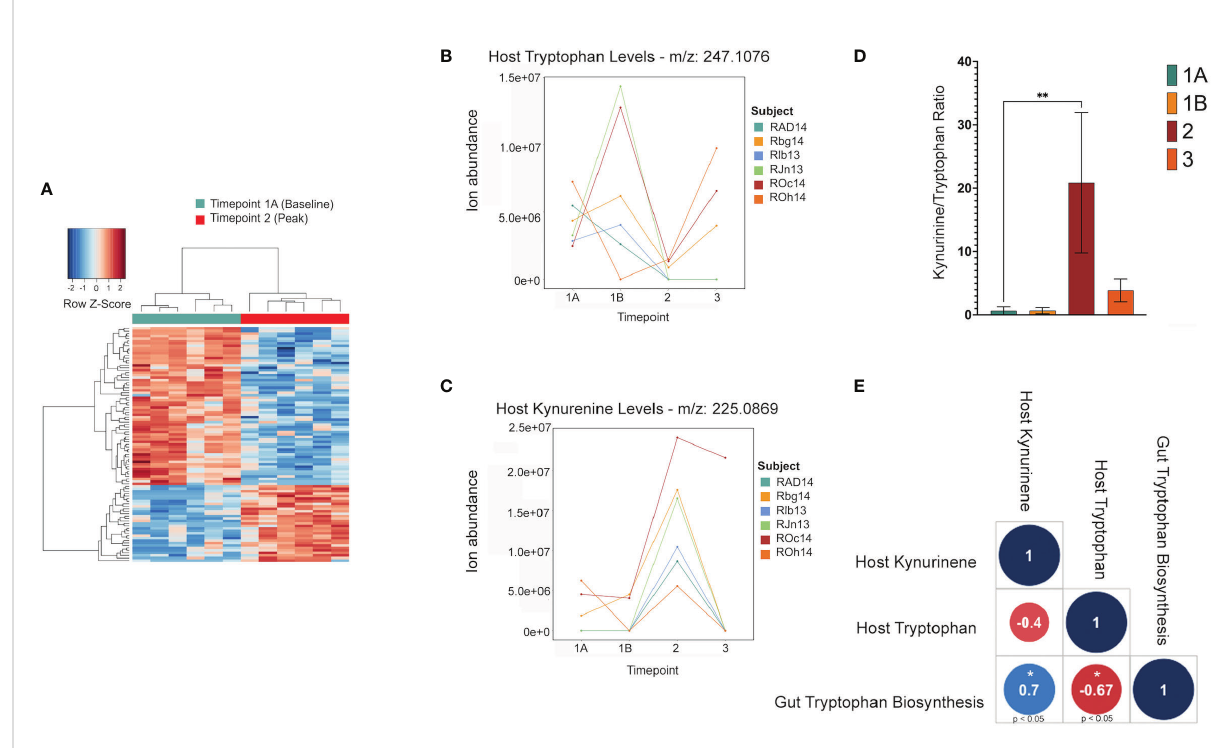
FIGURE 4 Shifts in the host tryptophan/kynurenine pathway may be linked to microbial production of tryptophan in the gut. This data shows major shifts in the host metabolome where red indicates a signi fi cant increase, and blue indicates a signi fi cant decrease (A) . LC-MS data of host metabolite samples throughout primary infection (TP1A-TP3, n=9) reveals Kynurinine peaks a TP2, while tryptophan decreases at TP2. Data shown is separated and colored by subject for trend clarity. This shift in the kynurenine/tryptophan ratio indicates IDO activity (B, C) . The tryptophan/ kynurenine ratio across the primary infection (TP1A-TP3, n=9) shows a signi fi cant shift (p=0.0073) from tryptophan to kynurenine in the host at TP2 (D) . Spearman correlation shows host kynurenine levels and host tryptophan levels to be linked to gut microbiome tryptophan production across the primary infection (p=0.0358, p=0.0499) (E)